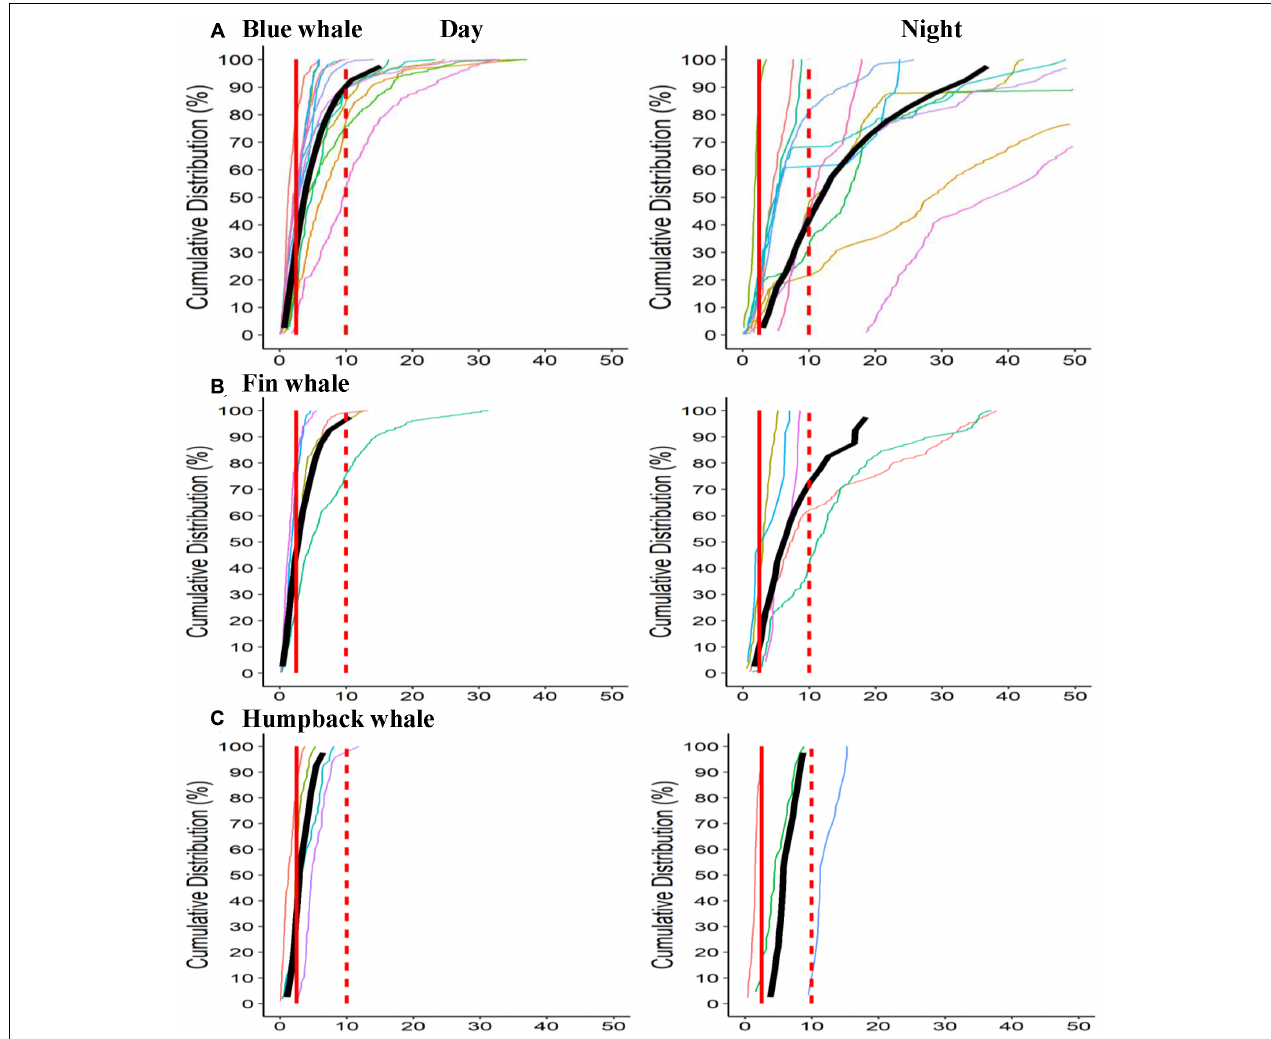
FIGURE 3 | Cumulative distance in kilometers from daytime centroid (mean of daytime positions). Positions standardized to one every 15 min interpolating as necessary (to avoid bias in sampling rate). Plots show distance from centroid point and lines show proportion of positions within that range on the Y -axis. Vertical lines show cut offs at 2.5 and 10 km range. Individual lines show cumulative positions for all cycles in each deployment. (A) Blue whale Day Night, (B) Fin whale, and (C) Humpback whale. TABLE 3 | Summary of movement parameters by species and period. Species Individuals Periods Mean period